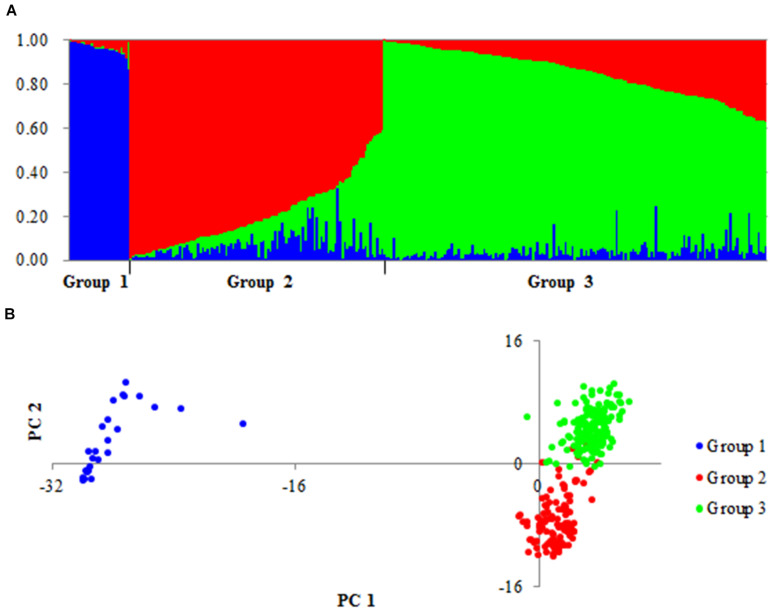
Population structure of 300 accessions based on 8,141 variations. (A) Genetic structure of three groups produced by structures 2.3.4. (B) PCA plots of all accessions based on the same number of markers.